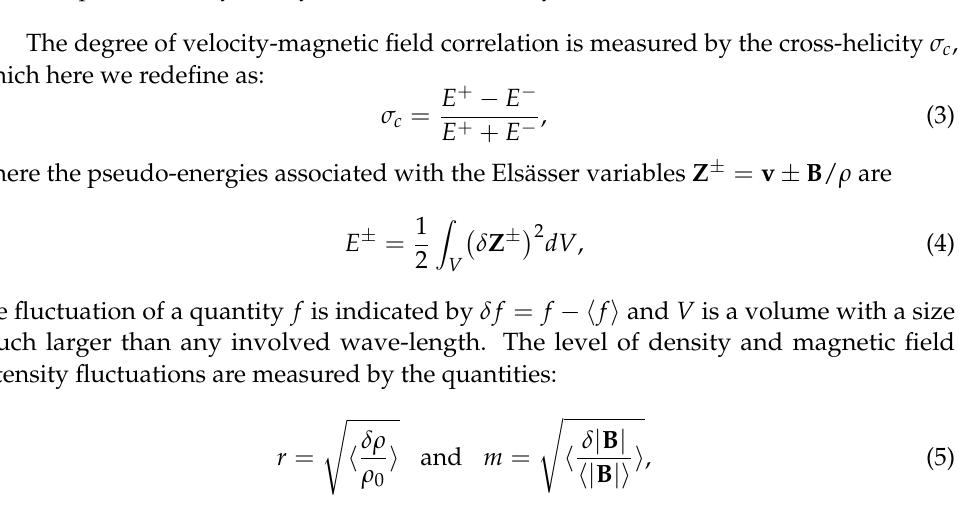
Figure 5. A circularly polarized pump wave with wave number k ( 0 ) and a smaller amplitude circu- larly polarized daughter wave with opposite helicity and wave number k A (cid:39) − k ( 0 ) are superposed. Black and blue arrows indicate the local orientation of the magnetic fluctuation of the pump wave and of the daughter wave, respectively. ( a ) At time t = t 0 , the two waves have the phase relation rep- resented in the figure. The green line represents the profile of the magnetic pressure B 2 /8 π . ( b ) The two waves are represented at the time t = t 0 + τ /4, with τ being the waveperiod. The magnetic pressure profile (green line) is not shifted with respect to the profile in the upper panel; therefore, it induces a quasi-stationary density fluctuation indicated by the red